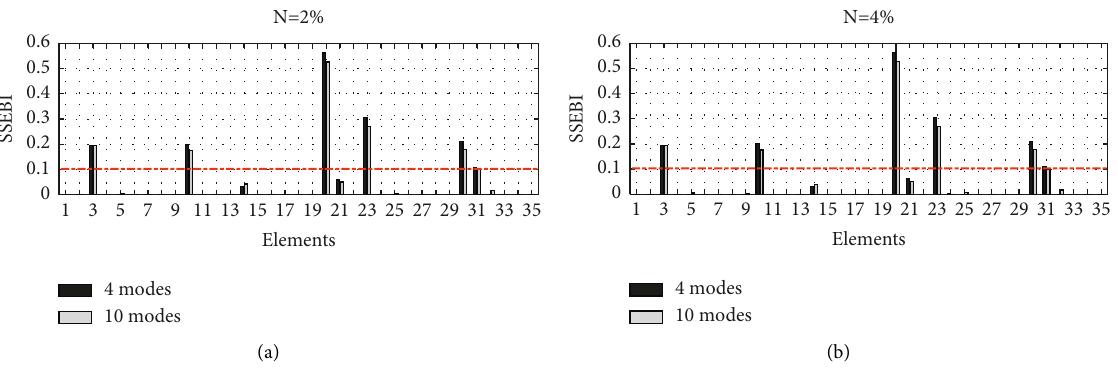
Figure 6: Damage detection results of step 1 for the 35-element planar truss; (a) damaged locations, 2% noise, (b) damaged locations, 4% noise. Table 2: Damage scenario for the 35-element planar truss. Element number